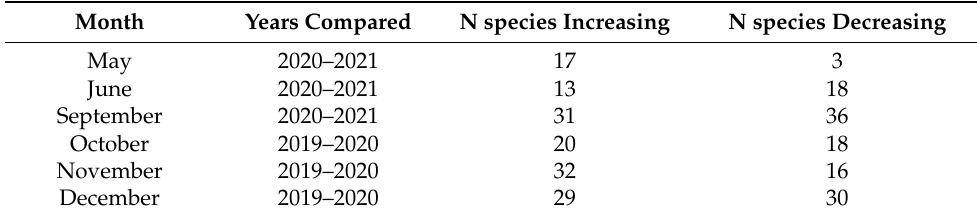
Figure 6. Changes in the composition of the bird community over time. Colors show different months, and symbol shapes reflect years. Each point represents one day’s observations (2017 data include both the shared and unshared vantage points combined). Table 4. Number of species increasing or decreasing in abundance between consecutive years. Only species observed at least twice in the study (2019–2021) were considered to minimize the impact of rare observations. Years Compared N species